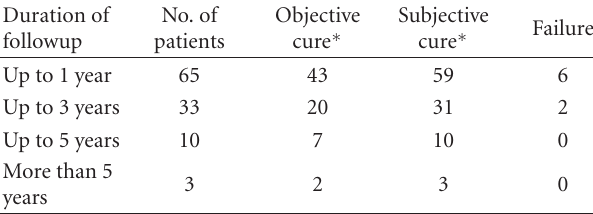
Table 4: Success and failure rates according to the duration of